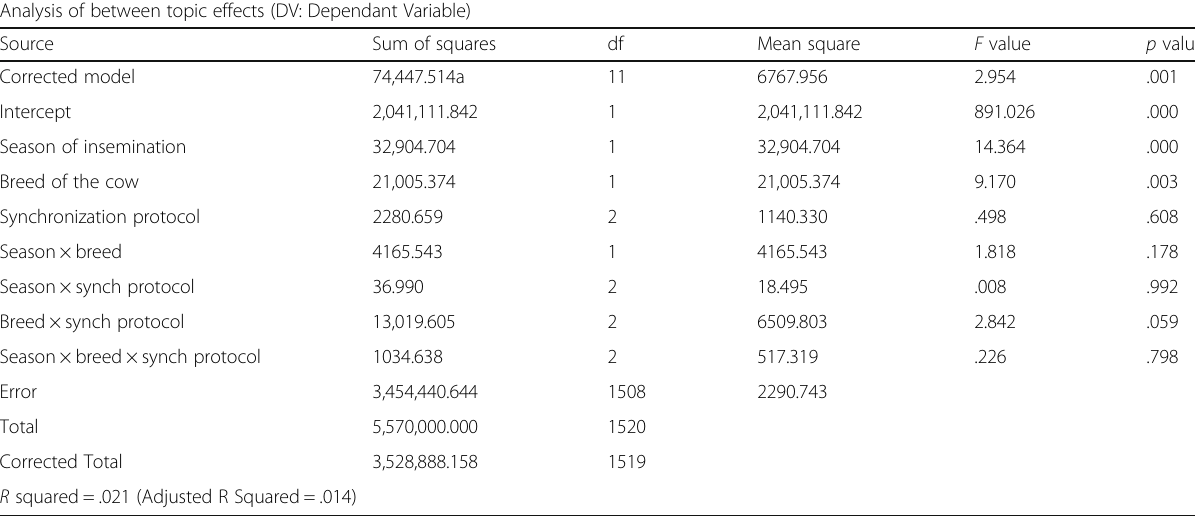
Table 1 Interactions between the tested variables and its effects on the pregnancy rate in dairy cows Analysis of between topic effects (DV: Dependant Variable)